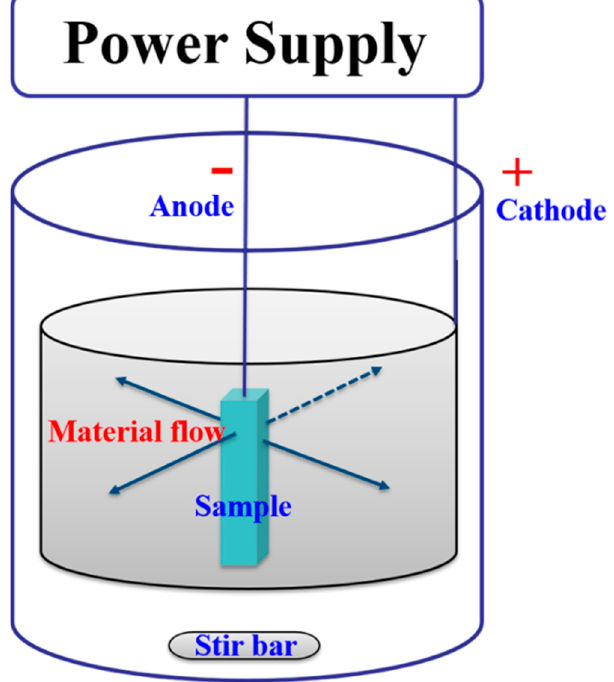
Figure 2. Schematic sketch of the sample and the ring-shaped cathode setup.